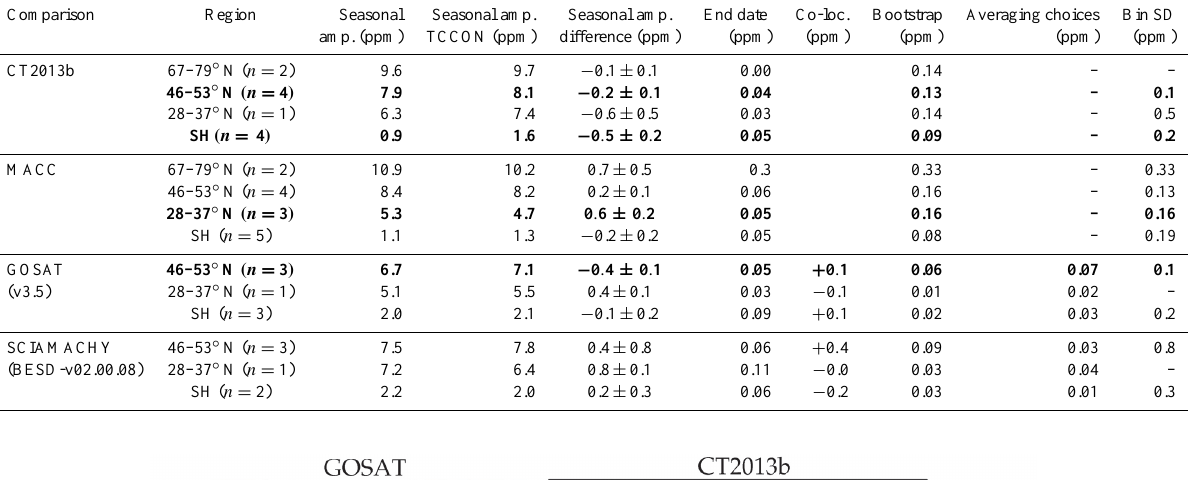
Table 3. Seasonal cycle amplitude for different latitudes. Stations included for satellites are Karlsruhe, Orléans, Park Falls, Lamont, Dar- win, Reunion (GOSAT), and Wollongong. Stations included for models are Sodankylä, Bialystok, Karlsruhe, Orléans, Park Falls, Lamont, Tsukuba, Saga, Darwin, Reunion, Wollongong, Lauder_120HR, and Lauder_125HR. Bold shows entries with statistically significant differ- ences.